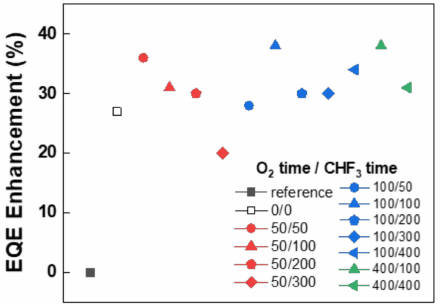
Figure 6. EQE enhancement according to RIE plasma process time compared to the bare